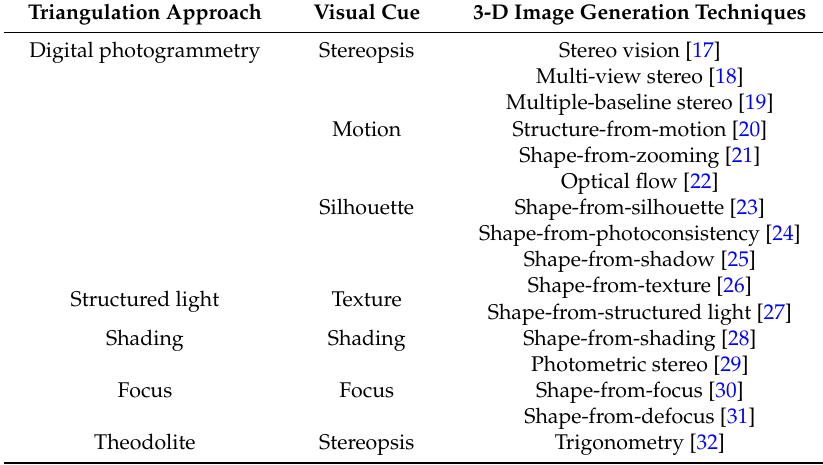
Table 1. List of some triangulation techniques for 3-D image generation found in the literature for different visual cues.